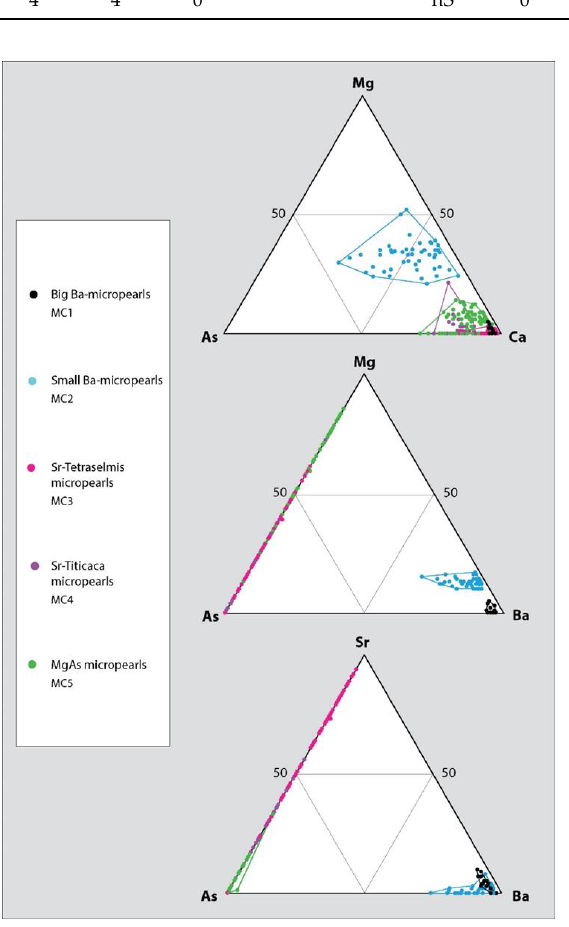
Figure 4. Mg-Ca-As, Mg-Ba-As, and Sr-Ba-As ternary representation of micropearls containing As and their morpho-chemical groups.